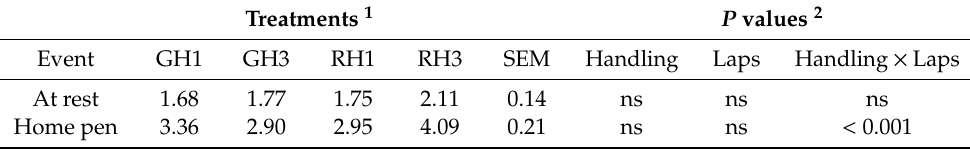
Table 6. Least square means of salivary cortisol level (ng / mL) by treatment and